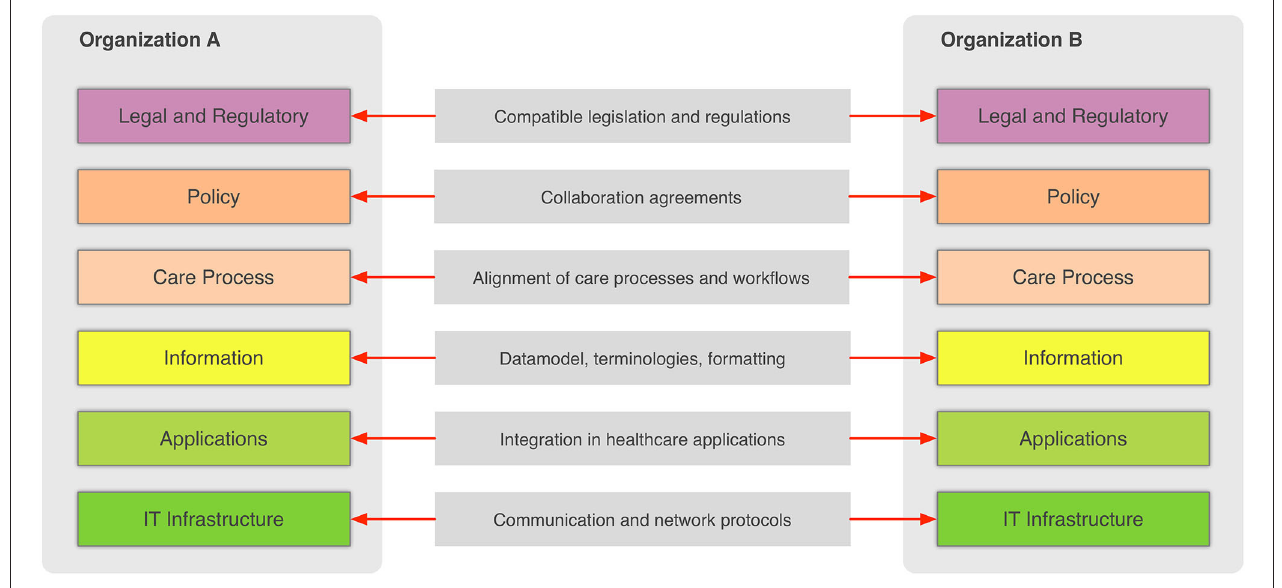
FIGURE 2 | Alignment of interoperability levels between two communicating